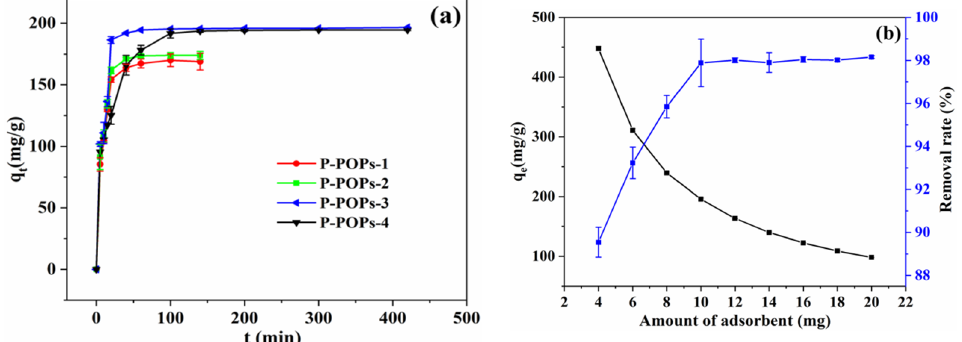
Figure 5. ( a ) The influence of adsorbent type and ( b ) dosage.